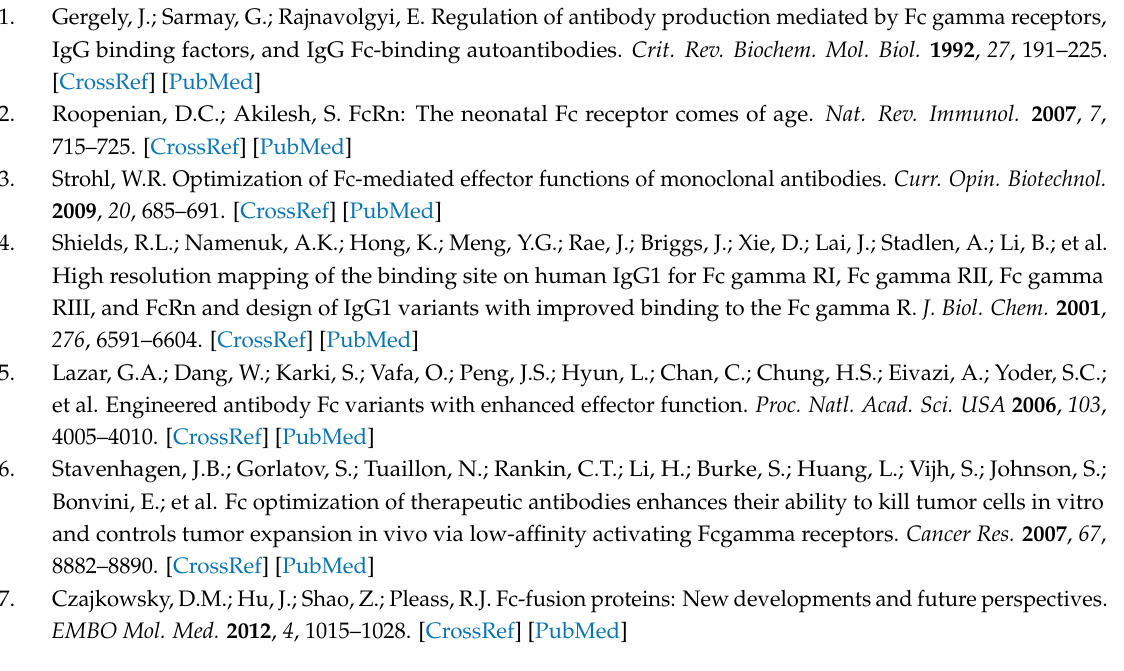
Figure S2: Altered lower hinge conformation of huIgG1 σ is not a requirement of crystal packing, Figure S3: Crystal packing does not prevent huIgG1 σ FG loop from adopting a flipped-out conformation, Figure S4: Conformation distribution of P329, Figure S5: Conformation distribution of P271, Figure S6: Interaction of lower hinge and FG loop with Fc γ R, Figure S7: REST MD enhances loop